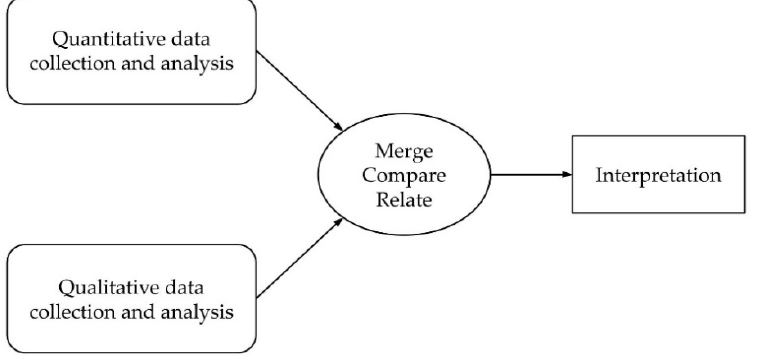
Figure 1. Convergent Triangulation Research Design: Convergence Model [16].